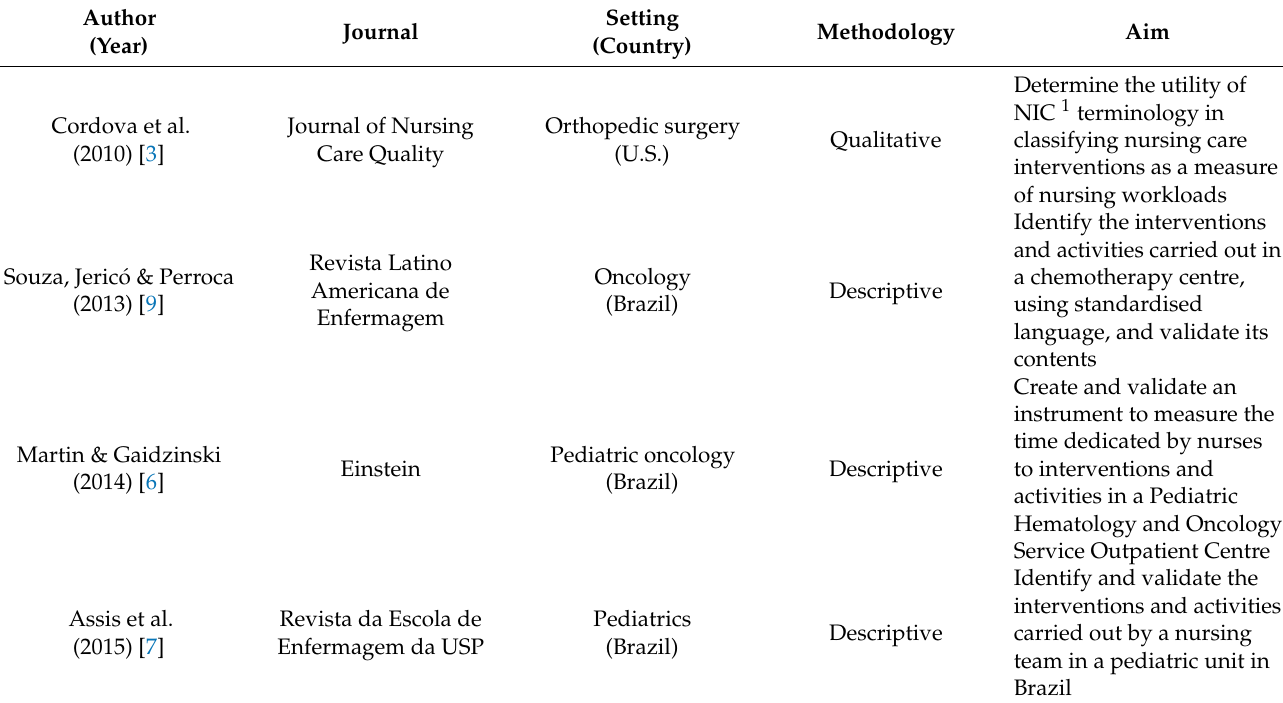
Table 1. Author, Year, Journal, Country, Methodology and Study Aims.